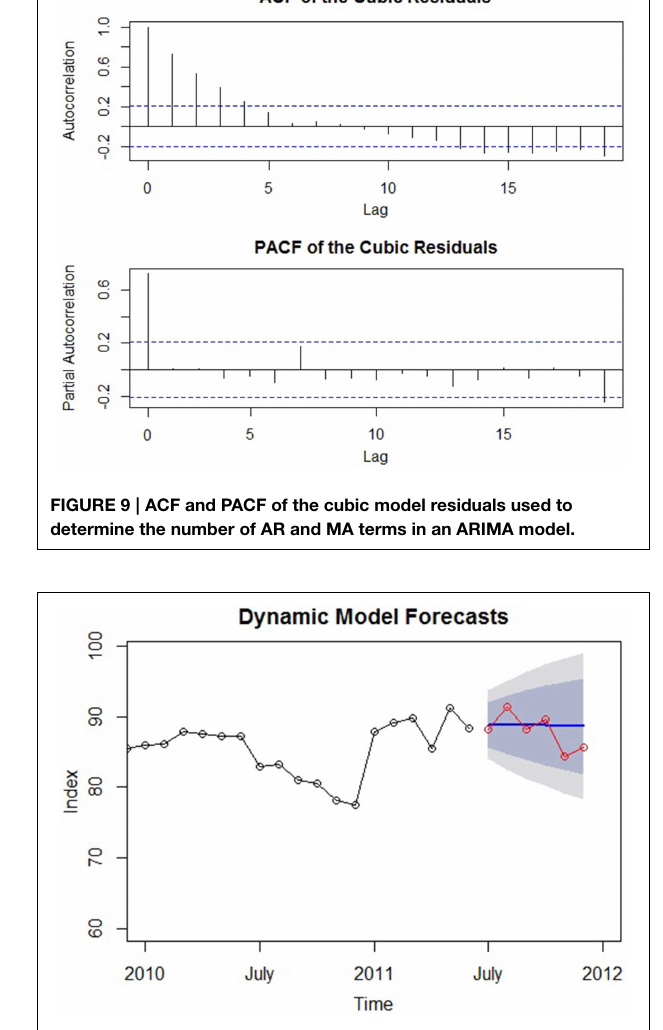
FIGURE 10 | Forecasts from the dynamic regression model compared to the observed values. The blue line represents the forecasts, and the red dotted line indicates the observed values. The darker gray region denotes the 80% confidence region, the lighter gray,